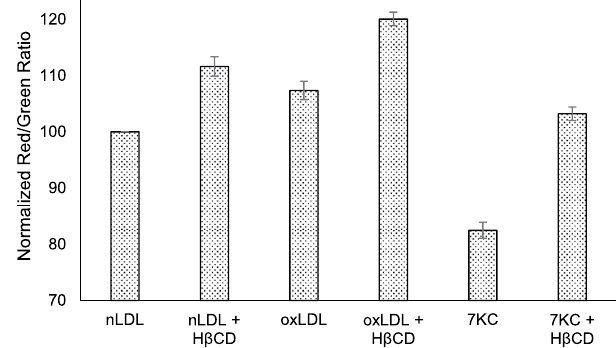
Figure 4. HP β CD attenuates the negative effects of cholesterol challenges. THP-1 cells were exposed to different LDL treatments over 7 days and then assessed for lysosomal membrane permeabilization using the acridine orange uptake assay. Acridine orange was excited at 488 nm and emissions recorded at 620 (red) and 520 nm (green). Lower red/green ratios are indicative of lysosomal instability. 7KC-LDL-induced lysosomal membrane permeabilization was significantly attenuated by H β CD ( p < 0.05), which was added to samples on day 6. Flow cytometry signal intensities are reported as a percent of control the red/green ratio (normal LDL- treated). H β CD treatment improved the ratio in all cases, indicating decreased lysosomal